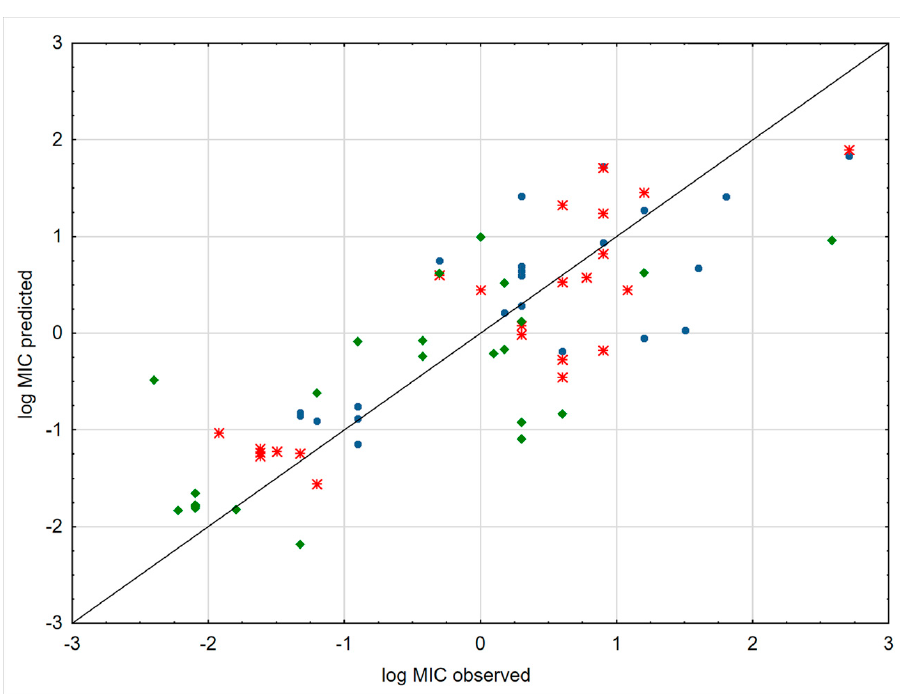
Figure 4. The performance comparison of the obtained QSAR models for each of the bacterial strains. Scatter plots comparing observed log MIC for Proteus vulgaris (green diamonds), Bacillus subtilis (blue circle), and Escherichia coli (red points) value with predicted value.